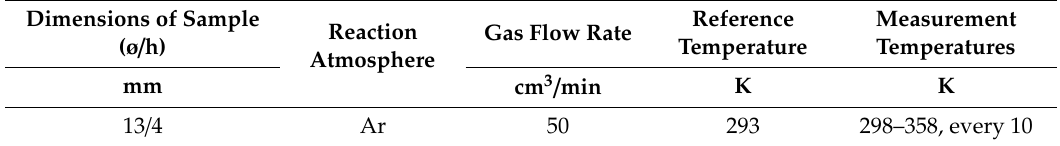
Table 2. Parameters for the measurement of thermal diffusivity. Table 3. Sample compositions for measurement. CNTs: Carbon nanotubes.